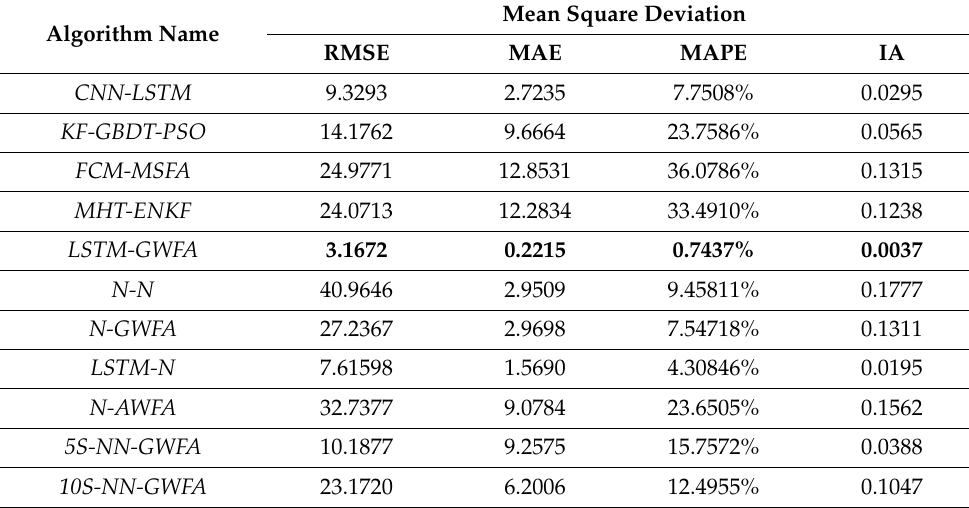
Table 2. Statistical results with 100 tracks in different algorithms.